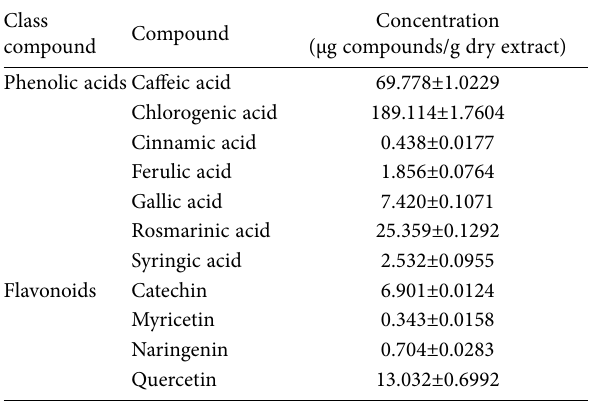
Table 2. The phenolic profile of the plant extract- 5 , as determined by LC–ESI–MS/MS.